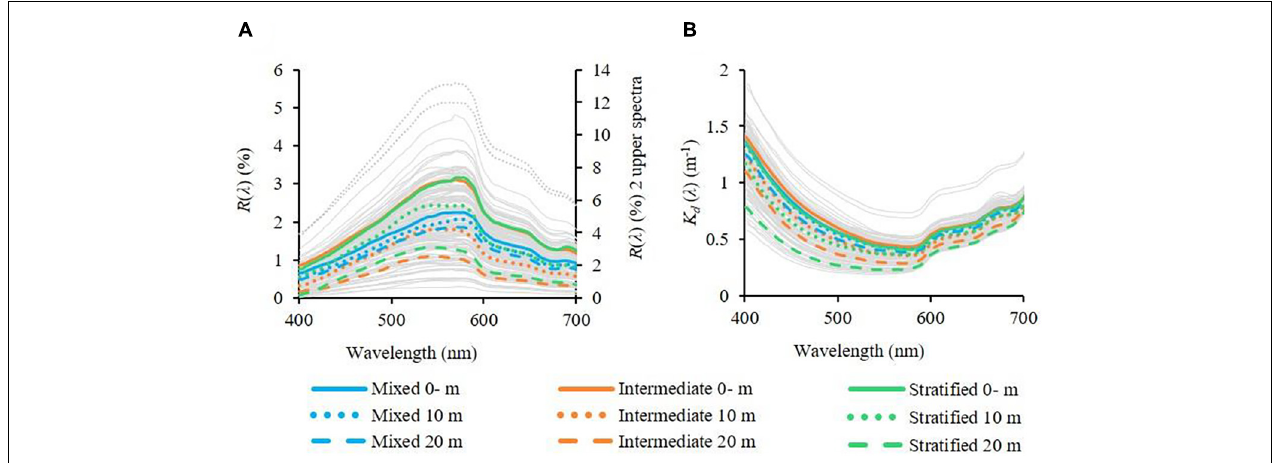
FIGURE 4 | Vertical variability of the simulated (A) spectral irradiance reflectance ( R ( λ )) and (B) spectral diffuse attenuation coefficient ( K d ( λ )) at 0 − m (surface layer), 10 m depth and 20 m depth. Coloured line represents the median spectra of the respective stratification situation. Note the secondary axis on panel (A) for the 2 spectra with highest